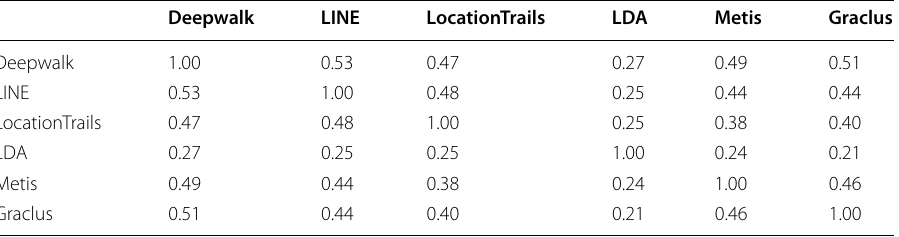
Table 2 Normalized mutual information between communities identified by methods on white- dominated neighborhoods